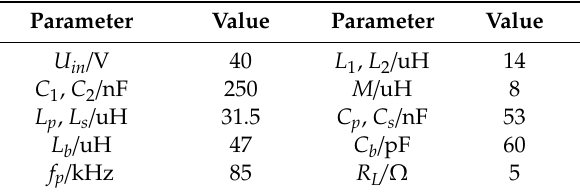
Table 1. Parameters of Power Transfer Channel.